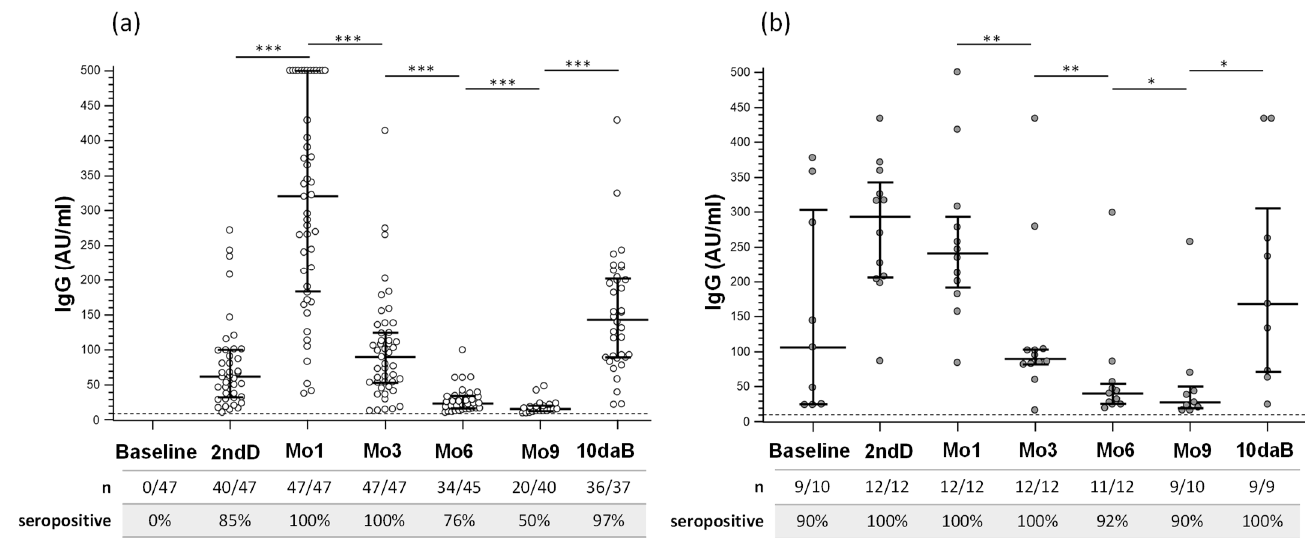
Figure 2. Serum IgG antibody response to SARS ‐ CoV ‐ 2 vaccine. Serum IgG response to COVID19 mRNA vaccine (Pfizer) measured in ( a ) SARS ‐ CoV ‐ 2 uninfected healthcare workers (naïve ‐